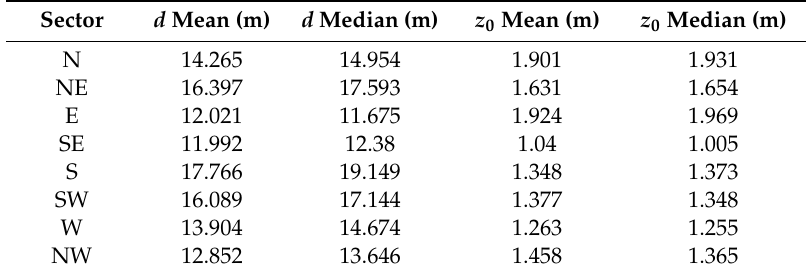
Table 7. Zero-plane displacement height and roughness length z 0 for the eight cardinal wind directions retrieved at BNCu